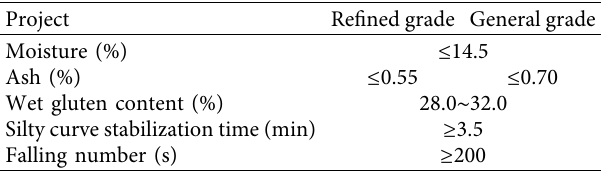
Table 8: Standard for wheat flour for dumplings.